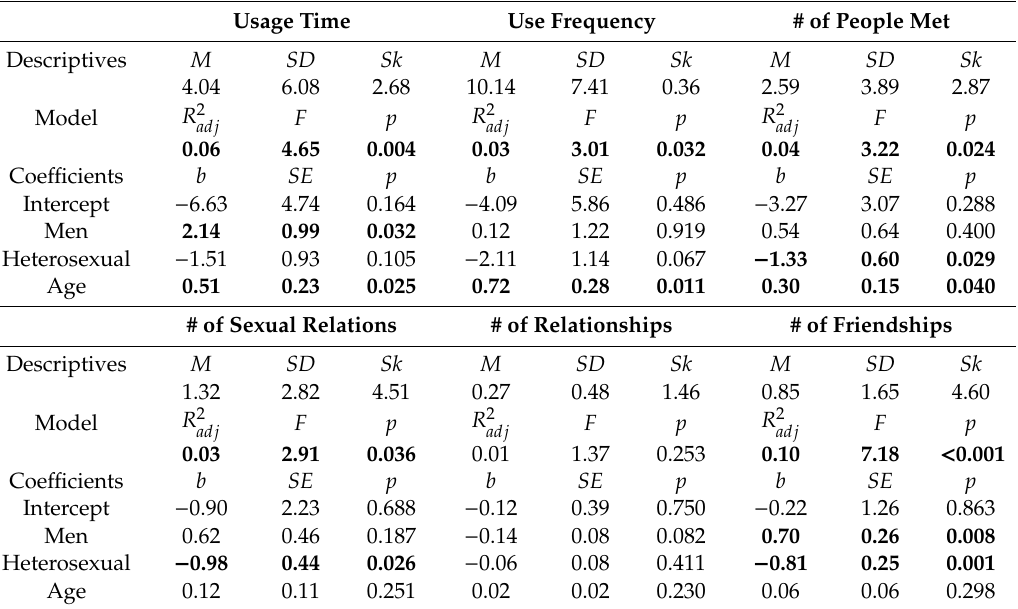
Table 3. Multiple regression analysis of the Tinder use